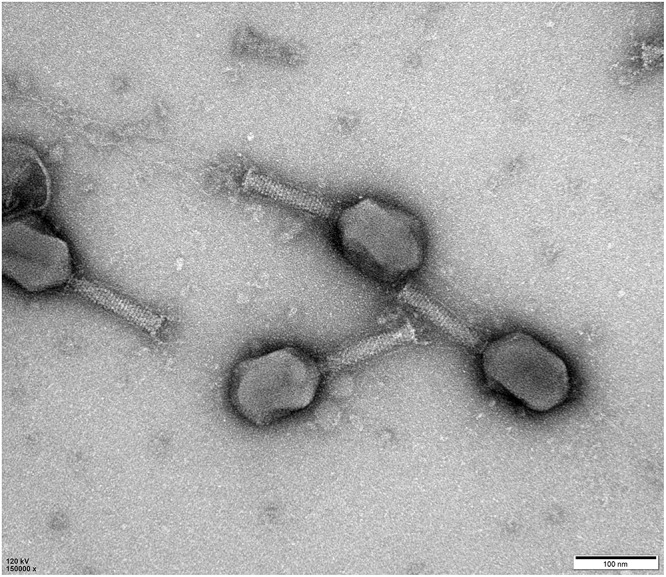
Morphology of phage vB_EaeM_φEap-3. Transmission electron micrograph of negatively stained phage vB_EaeM_φEap-3 at × 150,000 magnification. The bar indicates 100 nm.